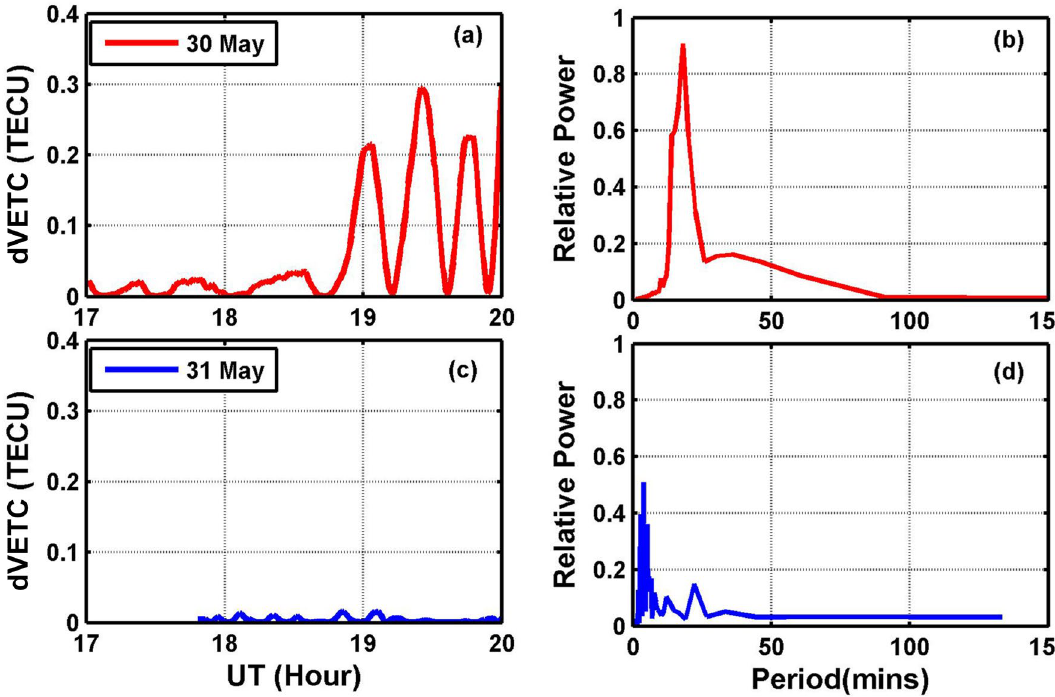
Figure 6. ( a , c ) dVTEC variation for Lucknow (LCKI) on 30 May and 31 May respectively ( b , d ) FFT of dVTEC at Lucknow on 30 May and 31 May 2014,